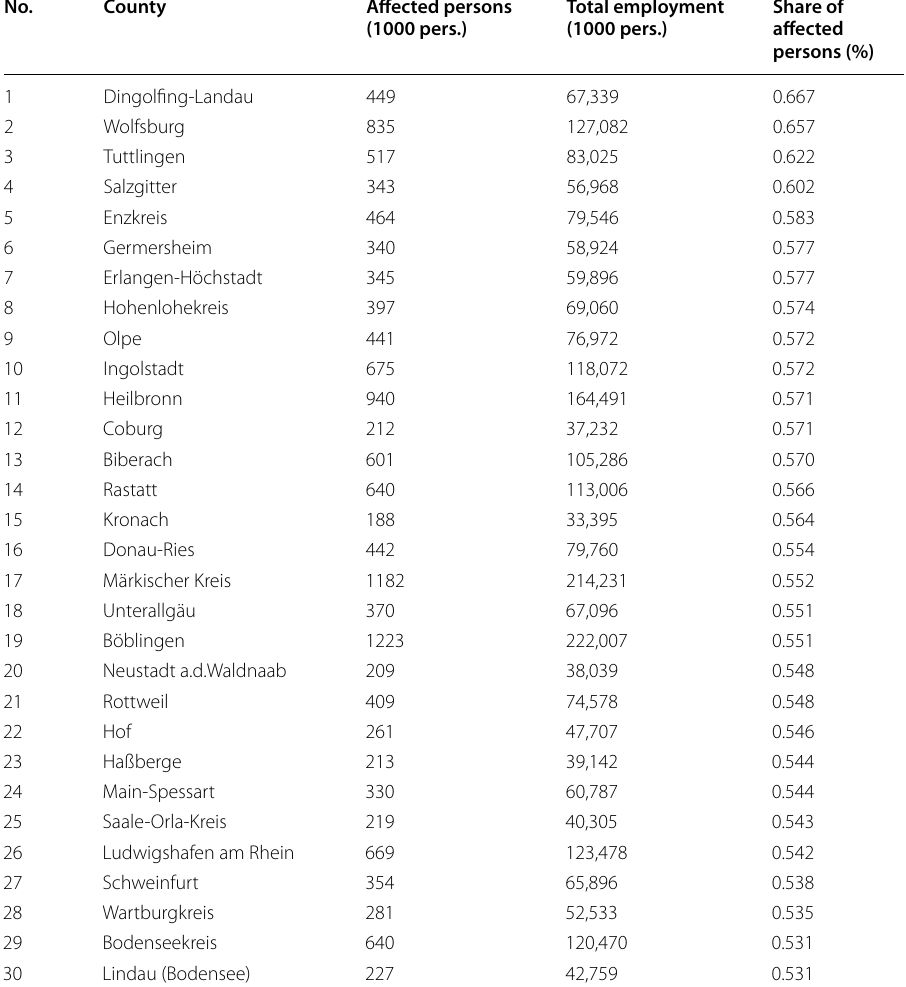
Ordered by share of affected persons. Source: World Input–Output Database, data for 2014, VGR der Länder (regional employment data for 2014 as of August 2017) and own calculations